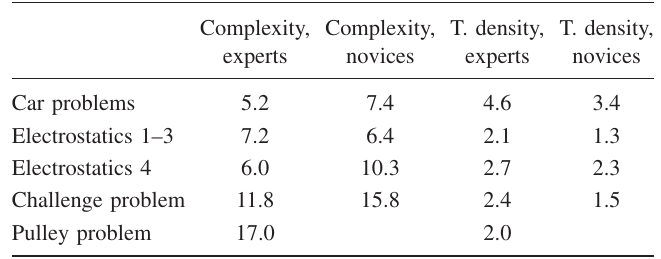
TABLE III. Complexity parameter describing the representa- tions used in student solutions, and density of transitions between representations (cid:1) per minute (cid:2) during those solutions. Organized by expert vs. novice and by